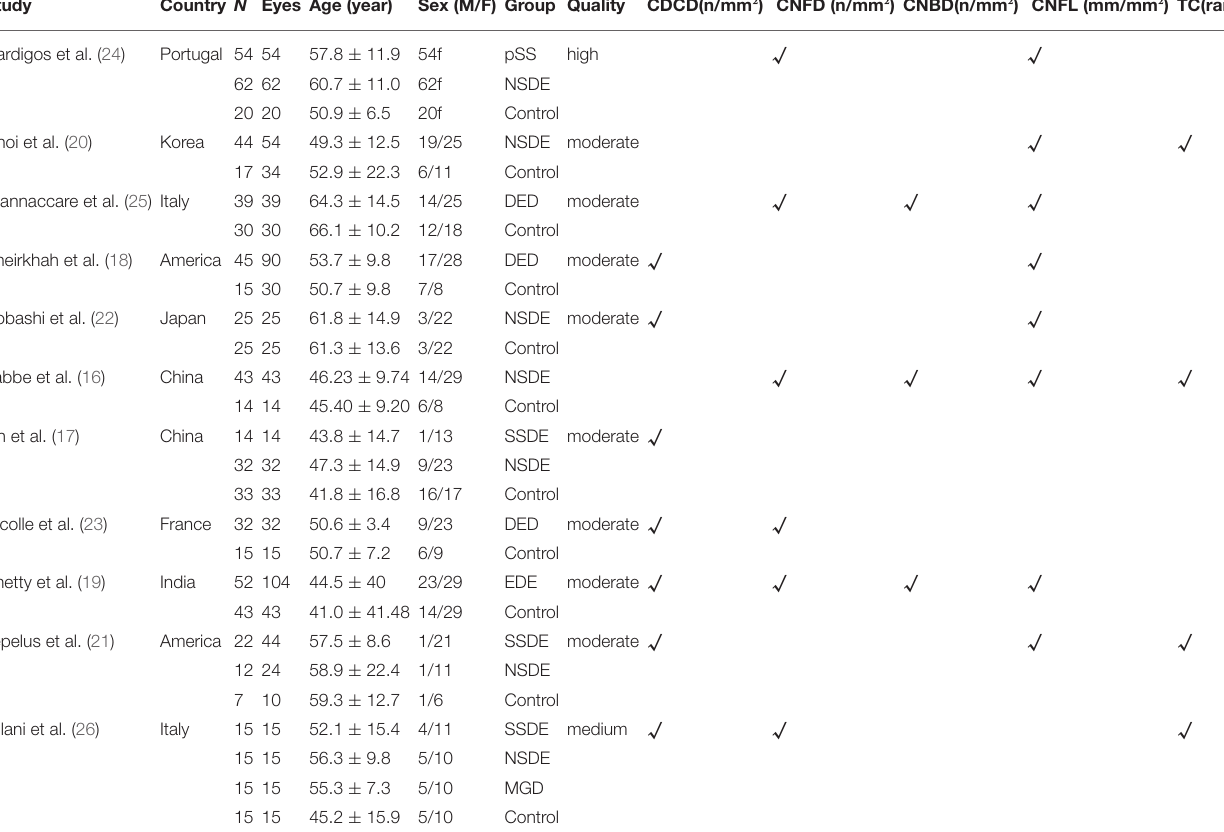
TABLE 4 | Characteristics of included trials.